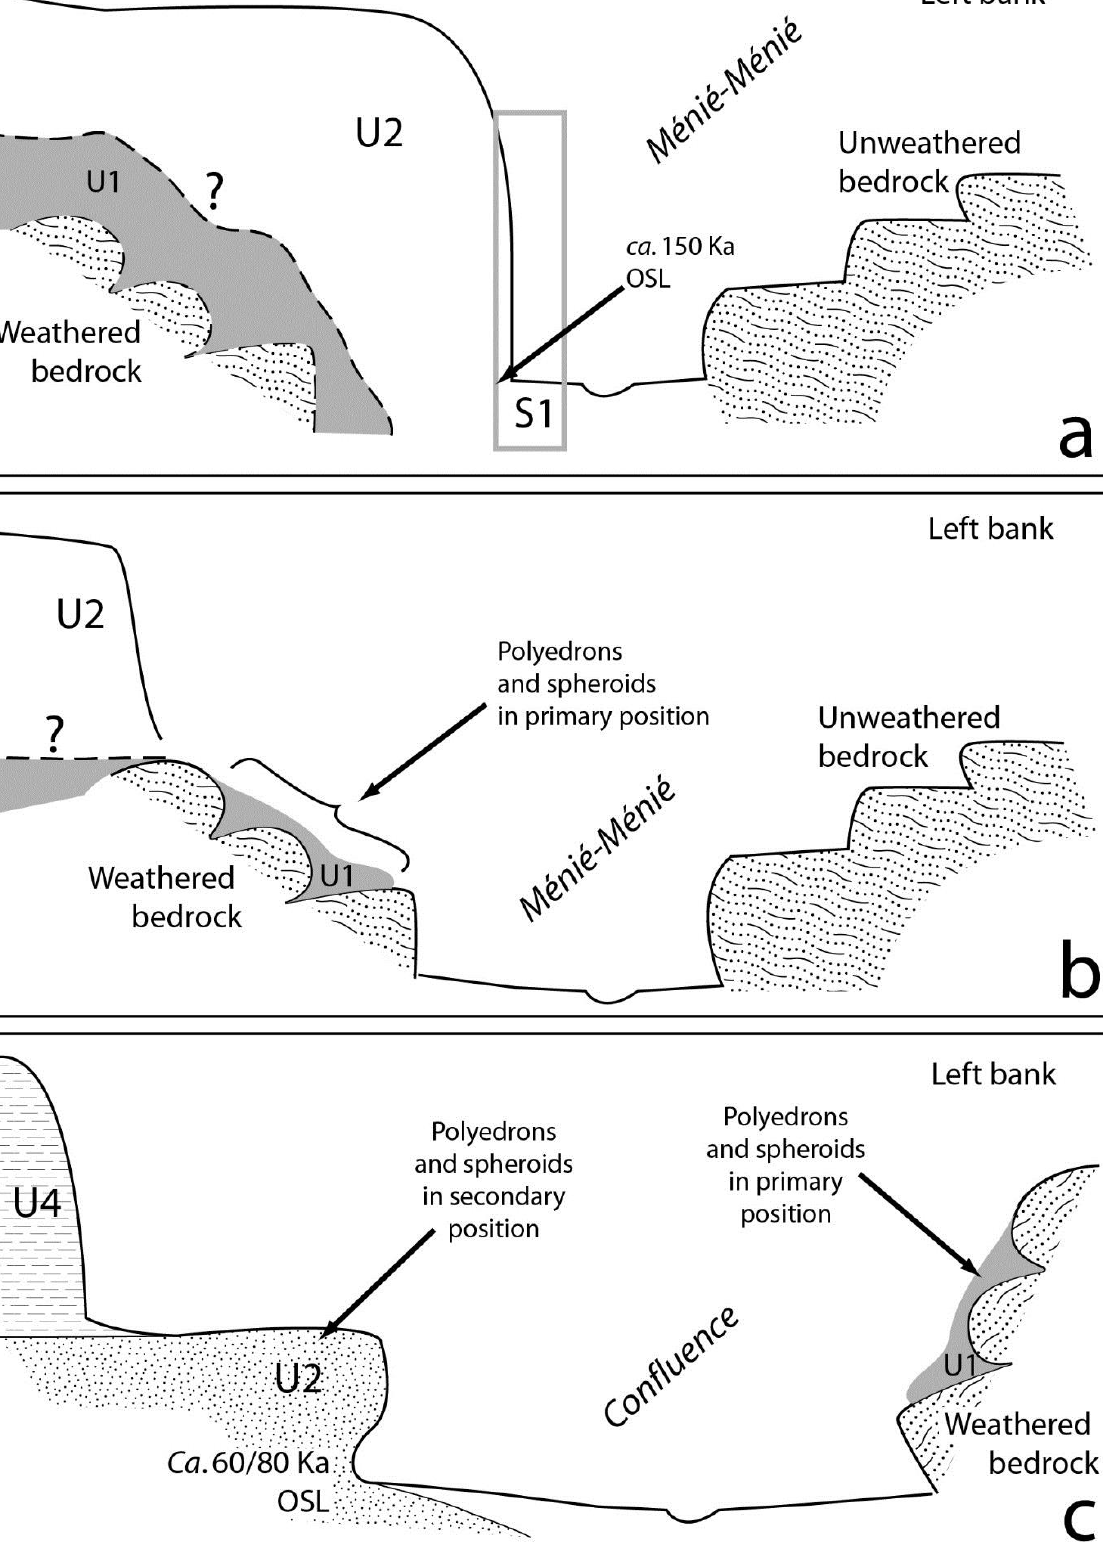
Figure 5. Synthetic profile of 3 sectors of the Ménié-Ménié, where lithic industry has been sampled (Courtesy of Sylvain Soriano, Mission archéologique